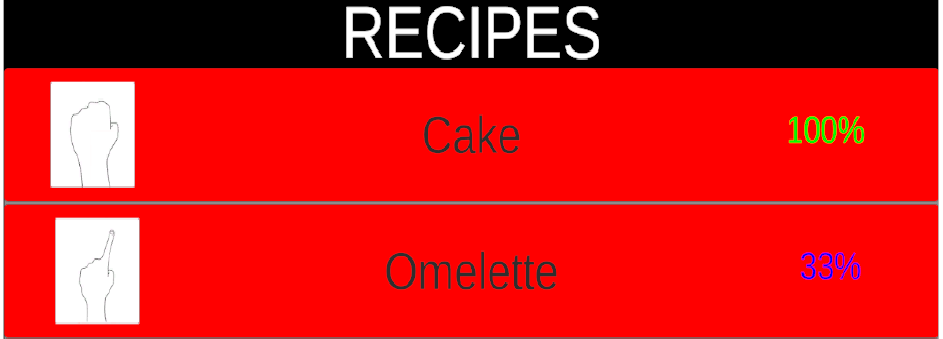
Figure 4. List of recommended recipes sorted according to the proportion of essential ingredients that are available.